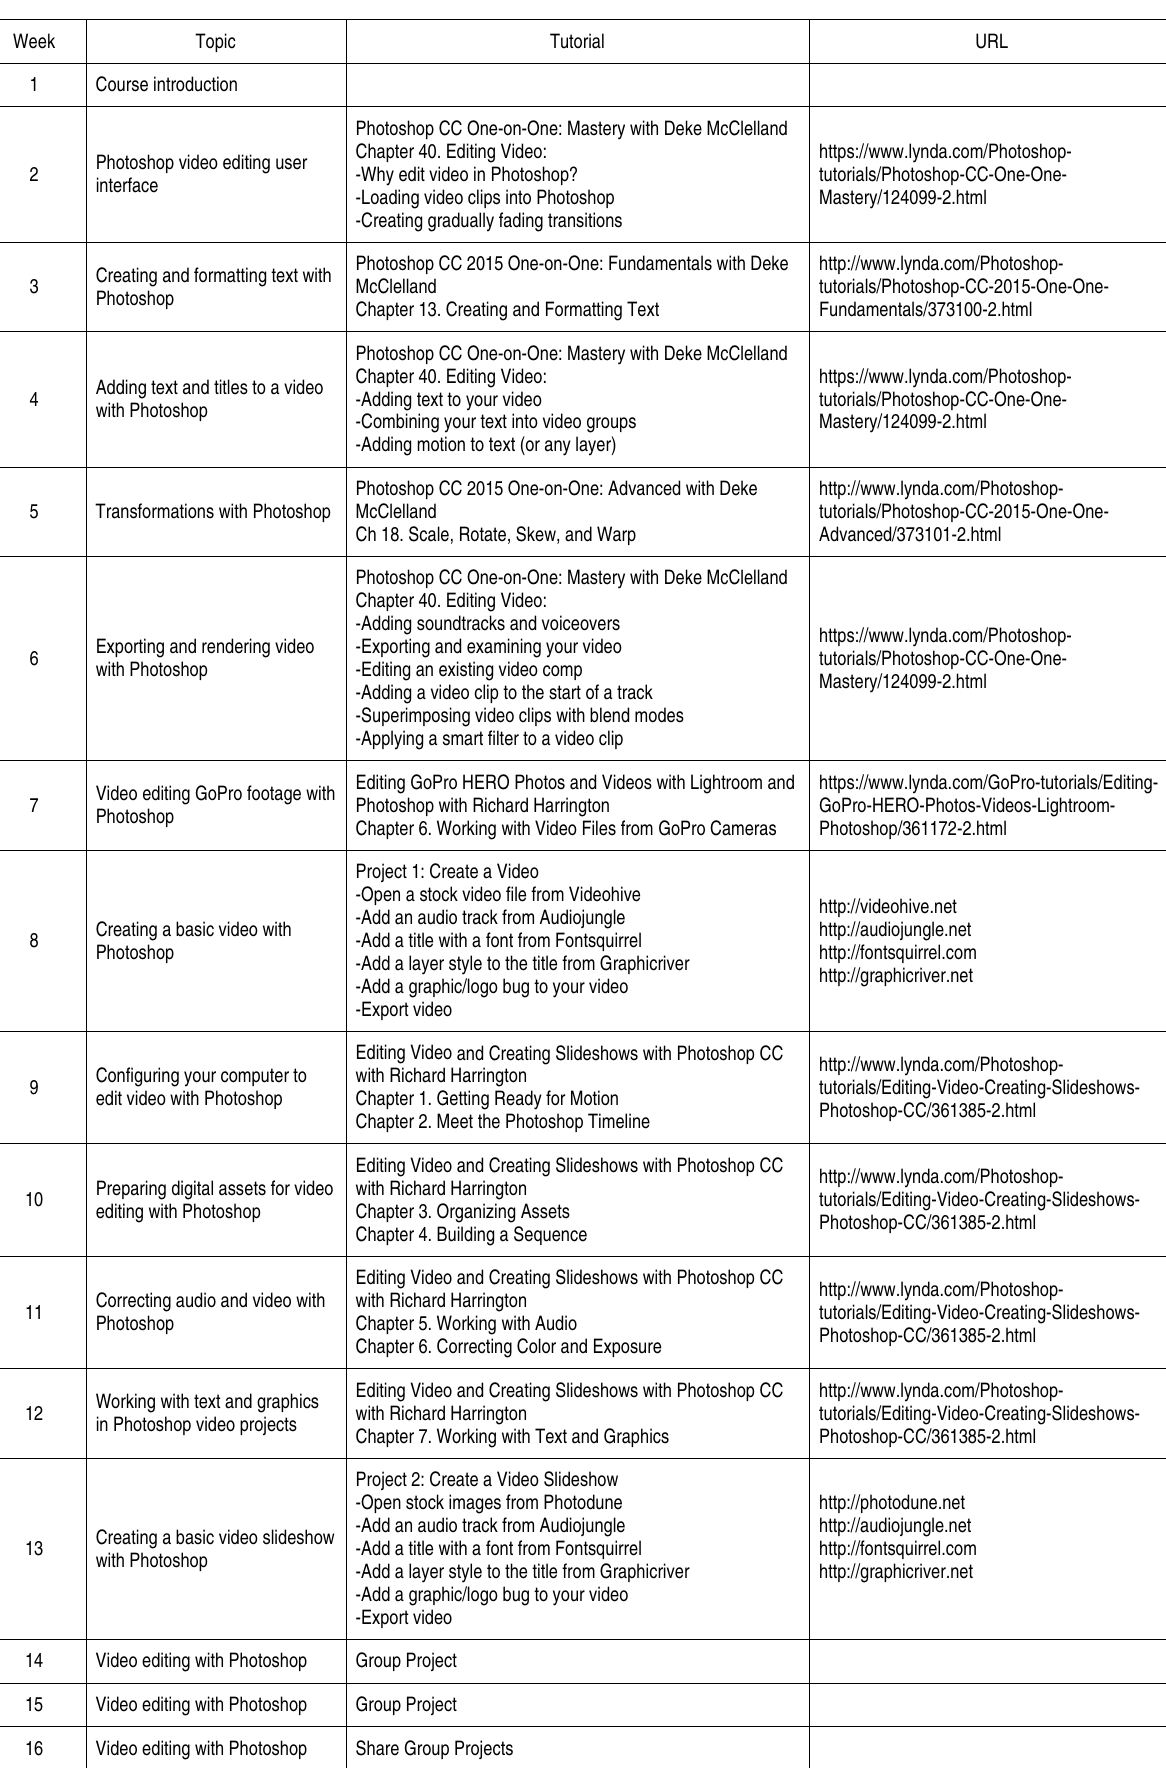
Table 1. 16-week semester course